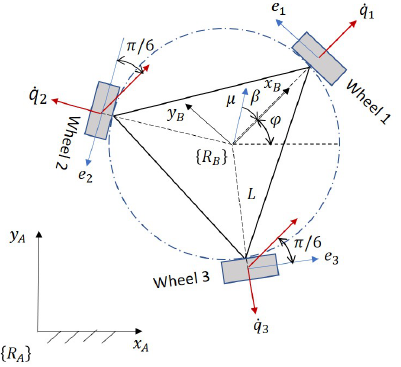
Figure 18. Graphical representation of the omnidirectional three-wheeled robot to obtain its forward kinematics. The robot can rotate on its own axis, rotate on the vertical axis and slide in all directions. Two coordinate systems are defined (Figure 18), the fixed coordinate system { R A } and the coordinate system at the point of interest { R B } in the robot; the x B axis is perpendicular to wheel 1; between the x A and x B axes the robot orientation angle ϕ is defined; the orientation of wheels 2 and 3 are measured with respect to the x B axis; the planes of each of the wheels are determined by the axes e 1 , e 2 and e 3